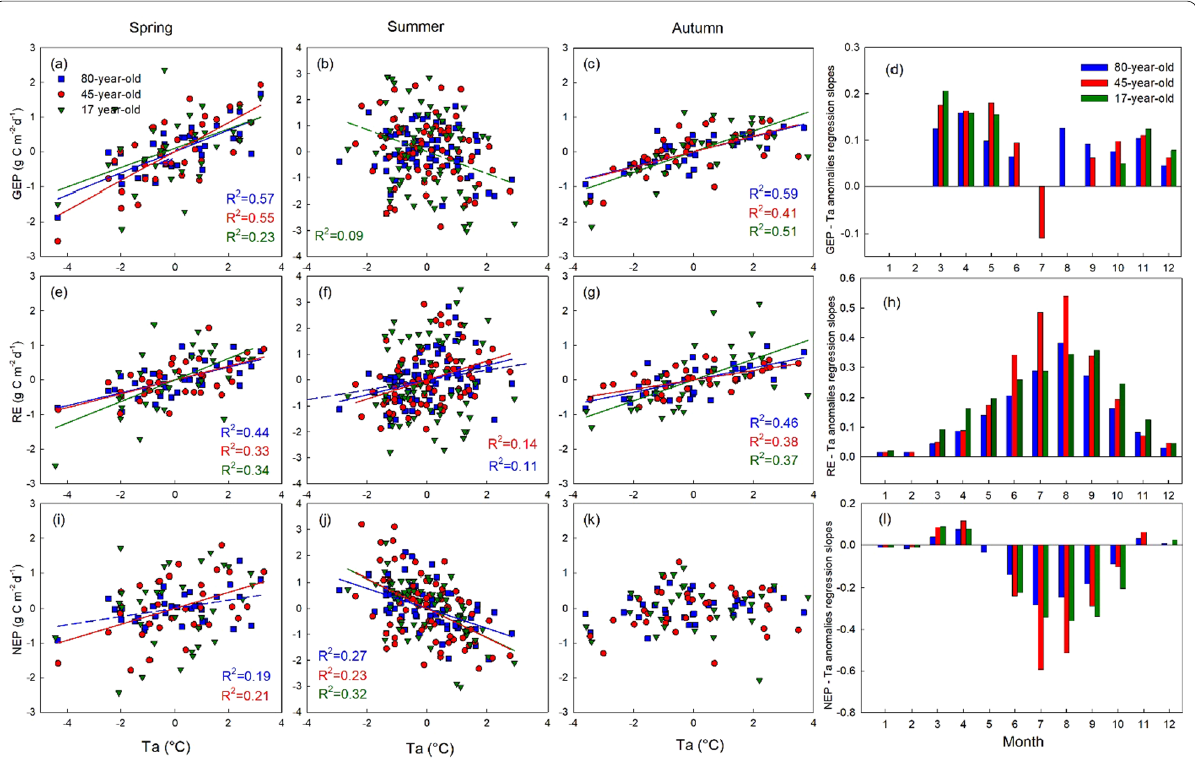
Fig. 4 Correlations between monthly air temperature (Ta) anomalies and a – c monthly gross ecosystem productivity (GEP), e – g ecosystem respiration (RE), and i – k net ecosystem productivity (NEP) anomalies in spring (AM), summer (JJAS) and autumn (ON) in the 80‑, 45‑, and 17‑year‑old stands. Significant linear regressions at p < 0.01 are shown as solid lines. Significant linear regressions at 0.01 < p < 0.05 are shown as dash lines. The slope of the linear relationship between daily Ta anomalies and daily GEP ( d ), RE ( h ), and NEP ( l ) in each month are shown when the regression was significant at p <